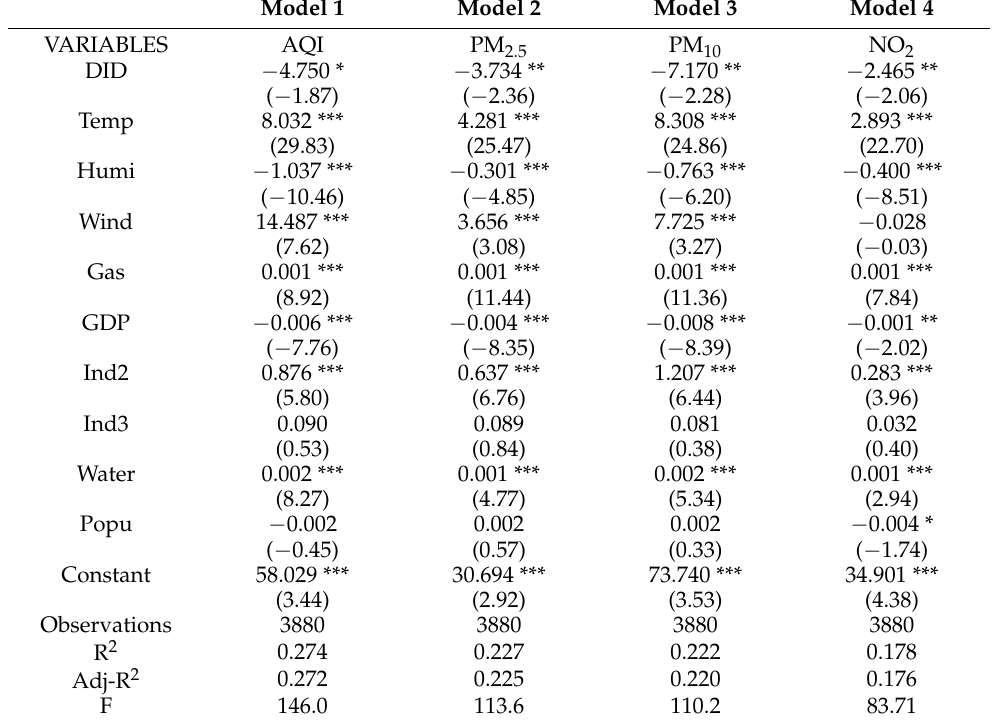
Table 5. DID model results.